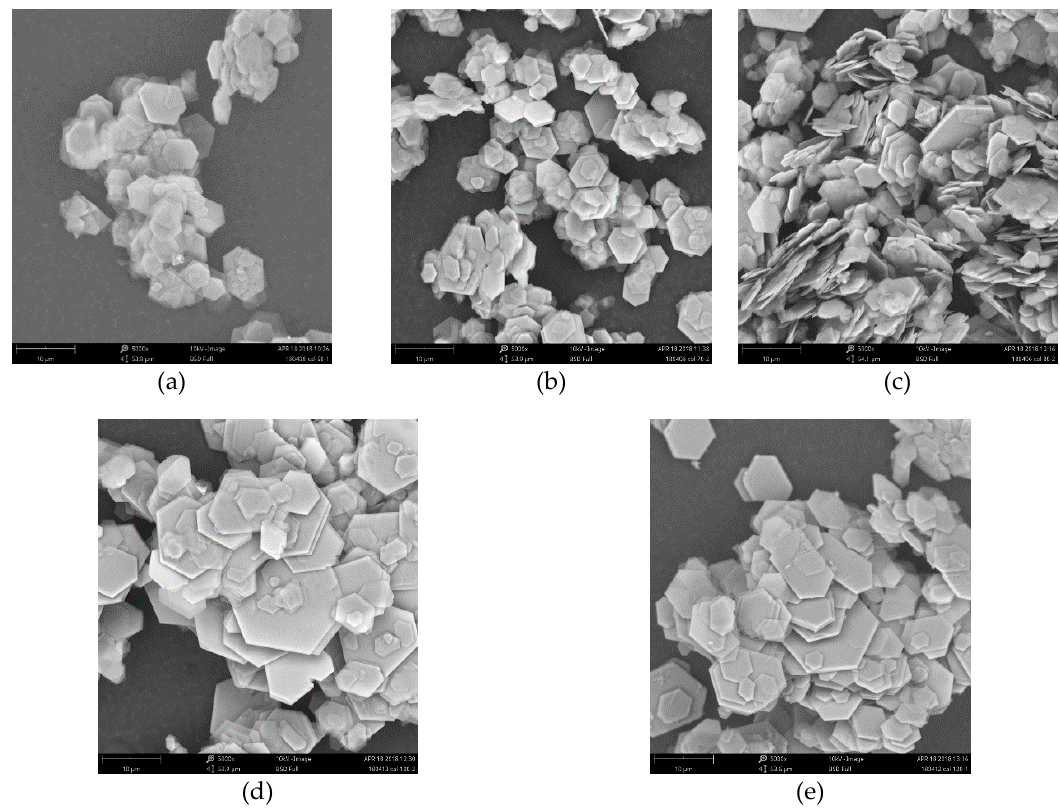
Figure 2. SEM images of CaAl-NO 3 − LDH samples synthesized at different temperatures ((a) 60 °C, (b) 70 °C, (c) 80 °C, (d) 100 °C, and (e) 120 °C).